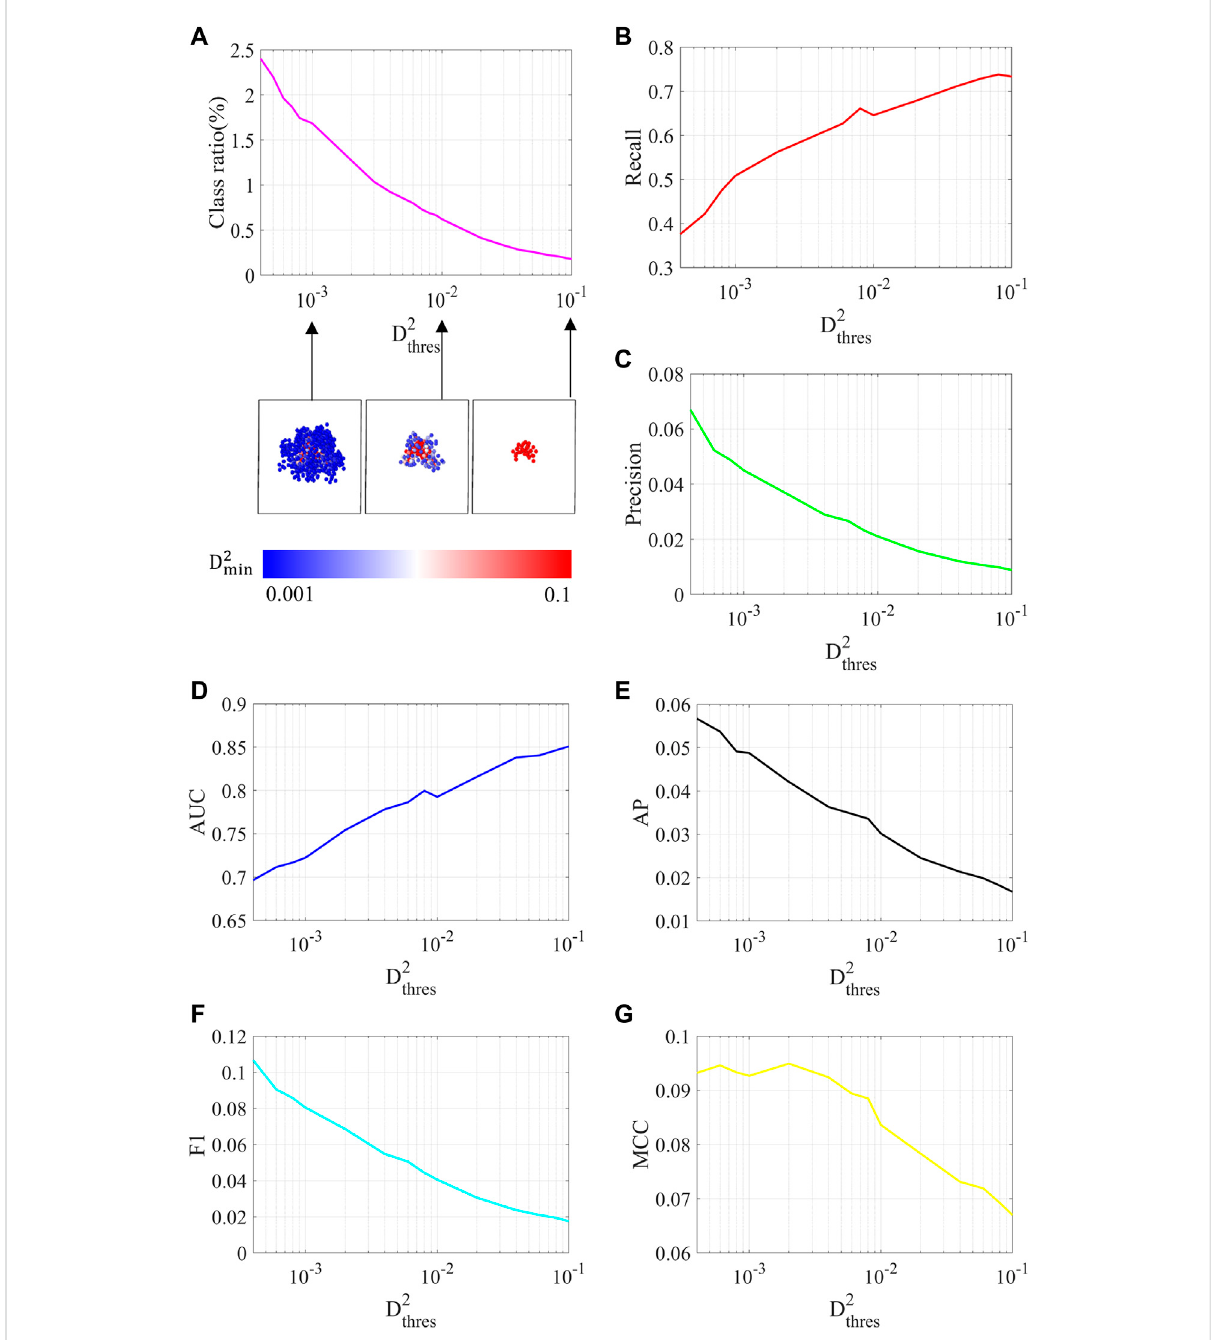
FIGURE 4 Forvariousnon-af fi nedisplacementthreshold values,the (A) class ratio, (B) recall, (C) precision, (D) AUC, (E) AP, (F) f1,and (G) MCC areplotted.